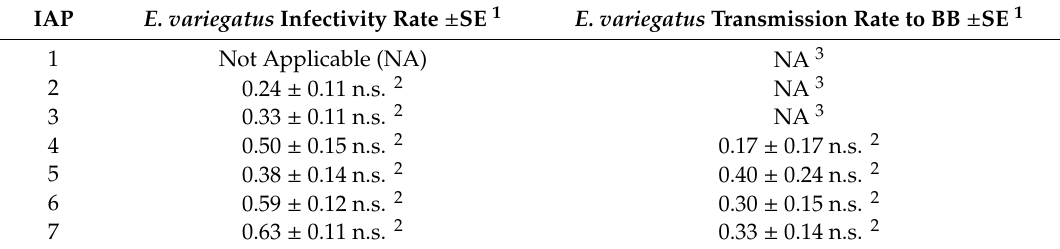
1 Standard Error according to the GLM output (SPSS Statistics); 2 Not significant; 3 Not